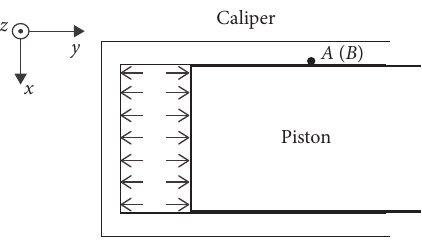
Figure 1: Schematic diagram of the piston-caliper coupling